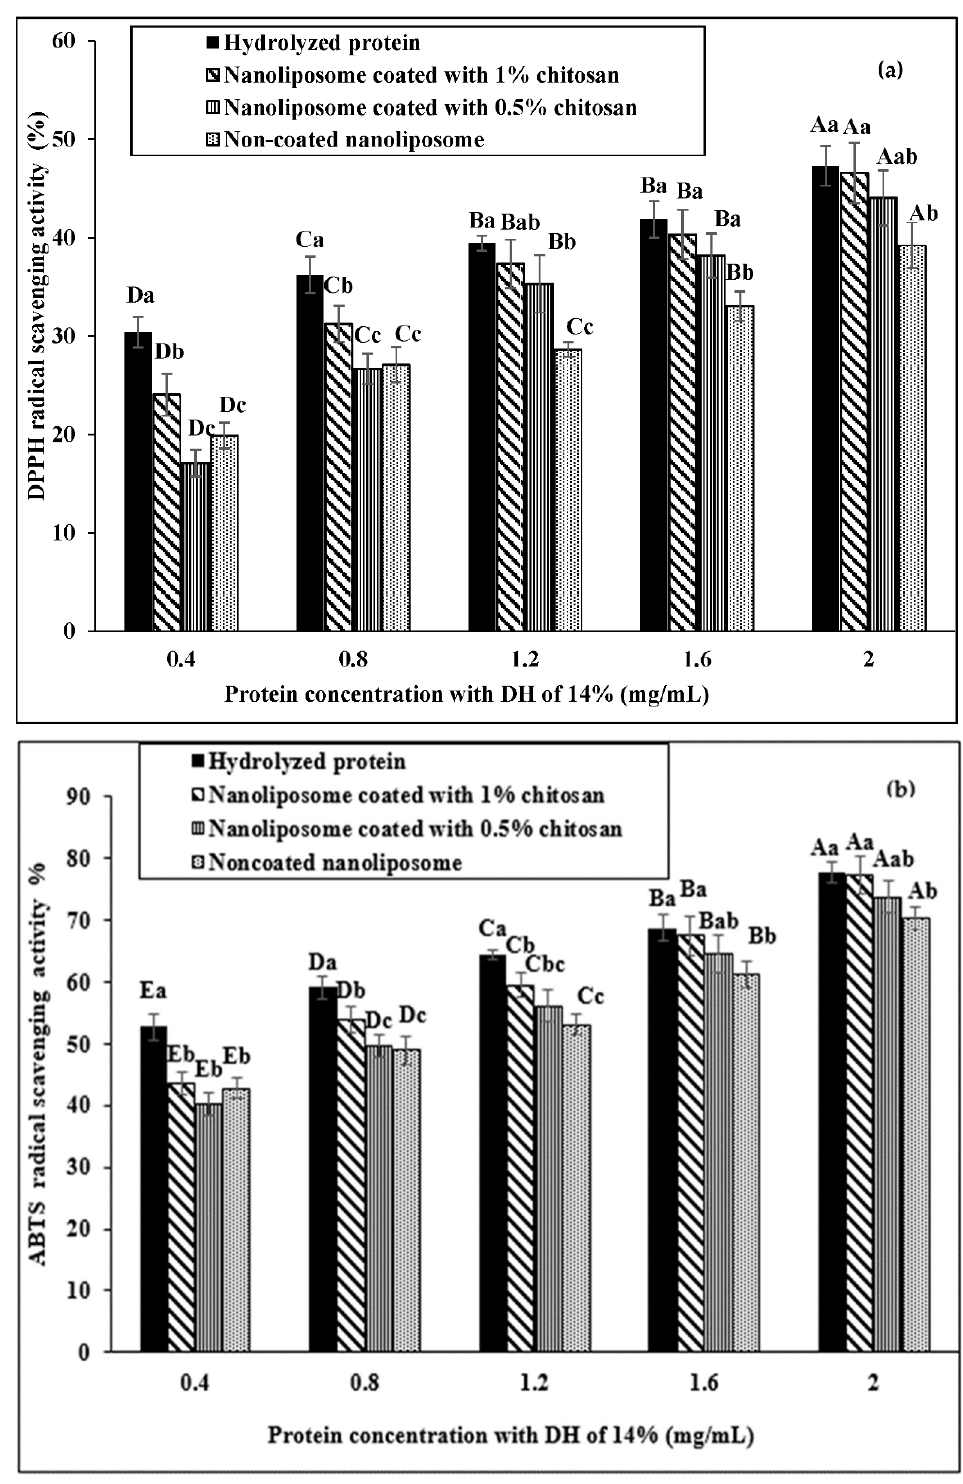
Figure 3. DPPH ( a ) and ABTS ( b ) radical scavenging capacity by hydrolyzed protein, non-coated nanoliposomes, 0.5% chitosan-coated nanoliposomes, and 1% chitosan-coated nanoliposomes. Different lowercase letters indicate a significant difference between groups at one concentration and different uppercase letters indicate a significant effect of the concentrations on the DPPH and ABTS scavenging.